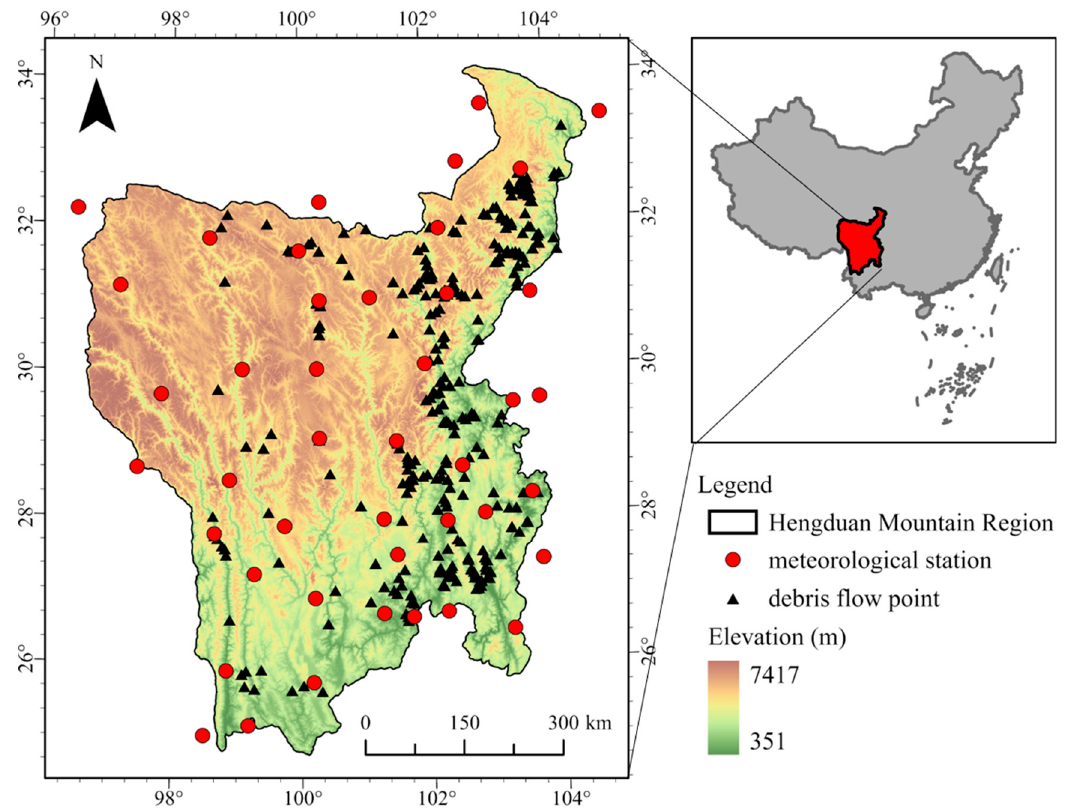
Figure 1. Map of the Hengduan Mountain region (HMR) showing the distribution of the debris flow points and meteorological stations in the period 2000–2020.